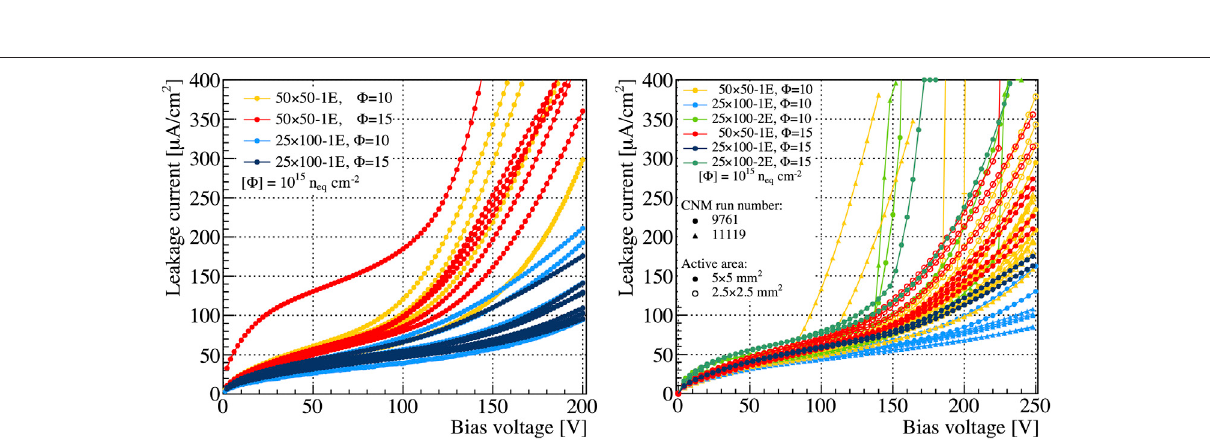
Frontiers in Physics |